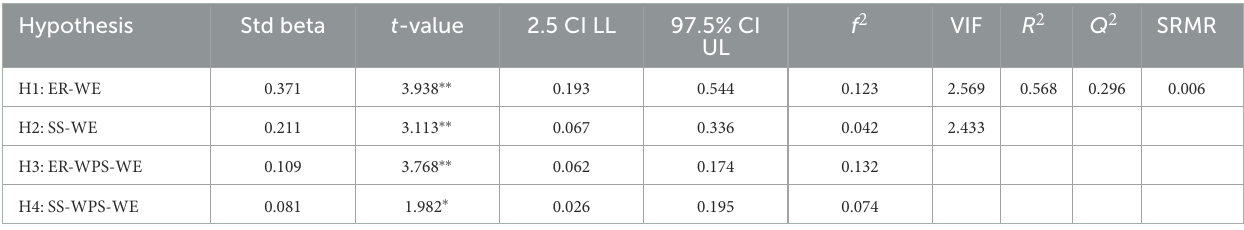
TABLE 3 Hypothesis testing of the structural model. Hypothesis